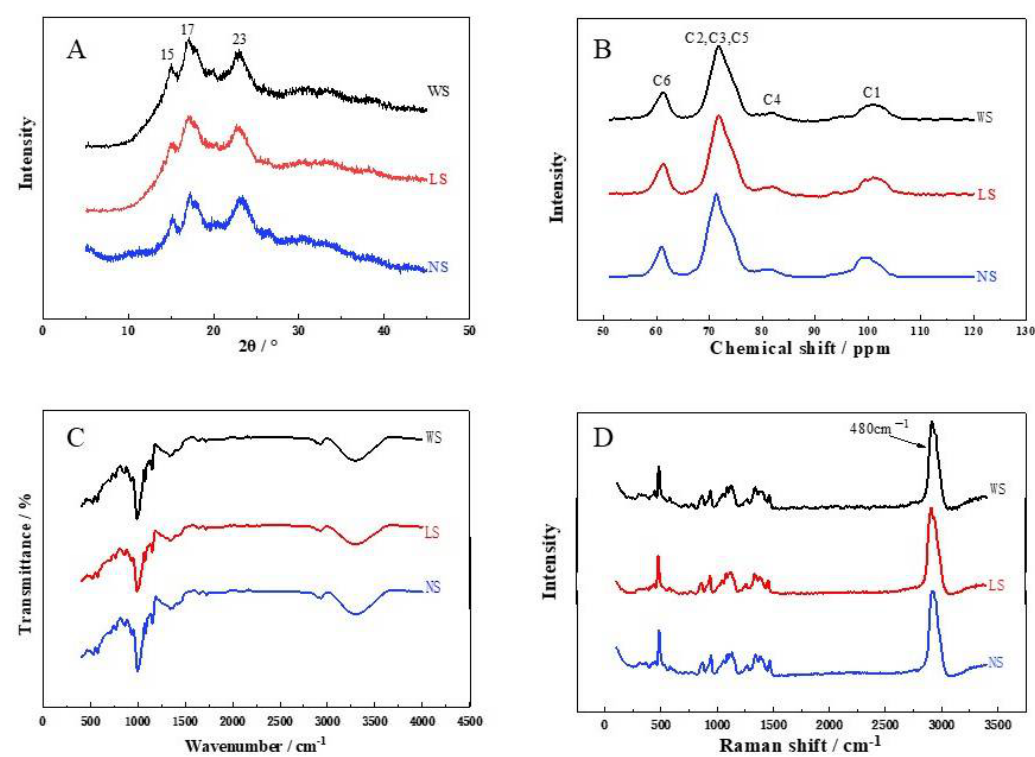
Figure 3. Crystal structure of starch samples extracted by different methods. ( A ) is the result of XRD diffraction patterns, ( B ) is the result of 13 C CP/MPS NMR spectra, ( C ) is the result of the FT-IR deconvoluted spectra, and ( D ) is the result of the Raman spectrum.